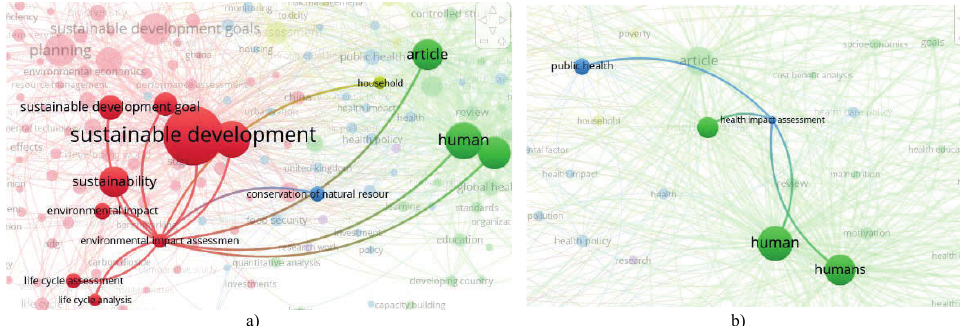
Fig. 3. Environmental impact assessments (a) and health impact assessments